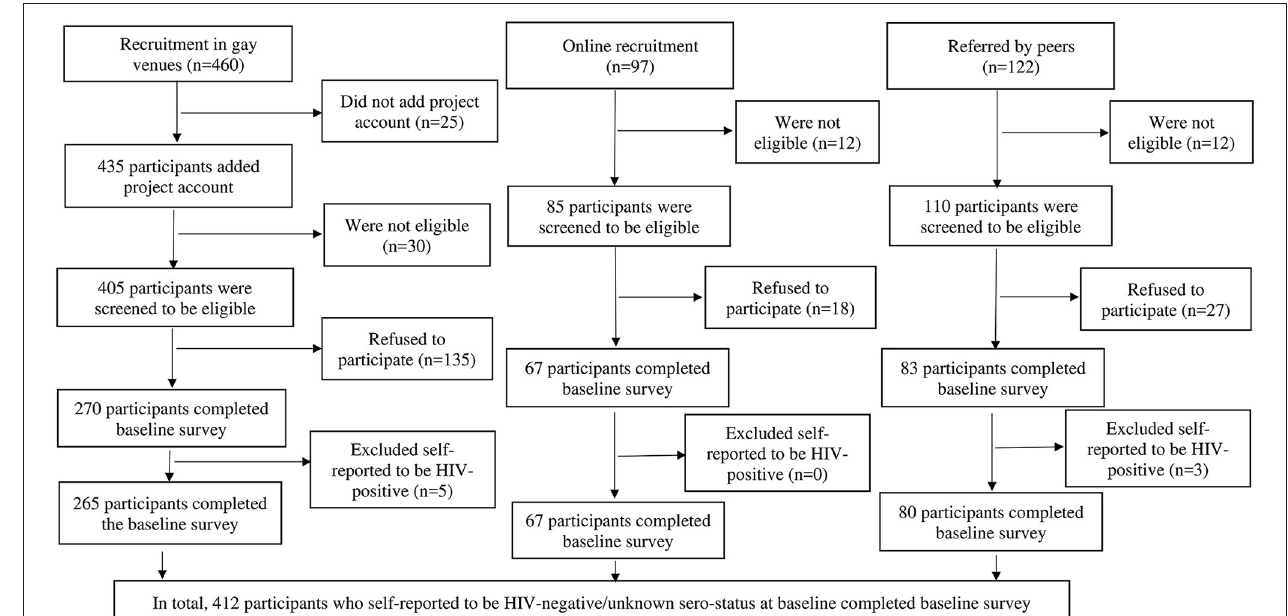
FIGURE 1 | Flowchart of data collection.